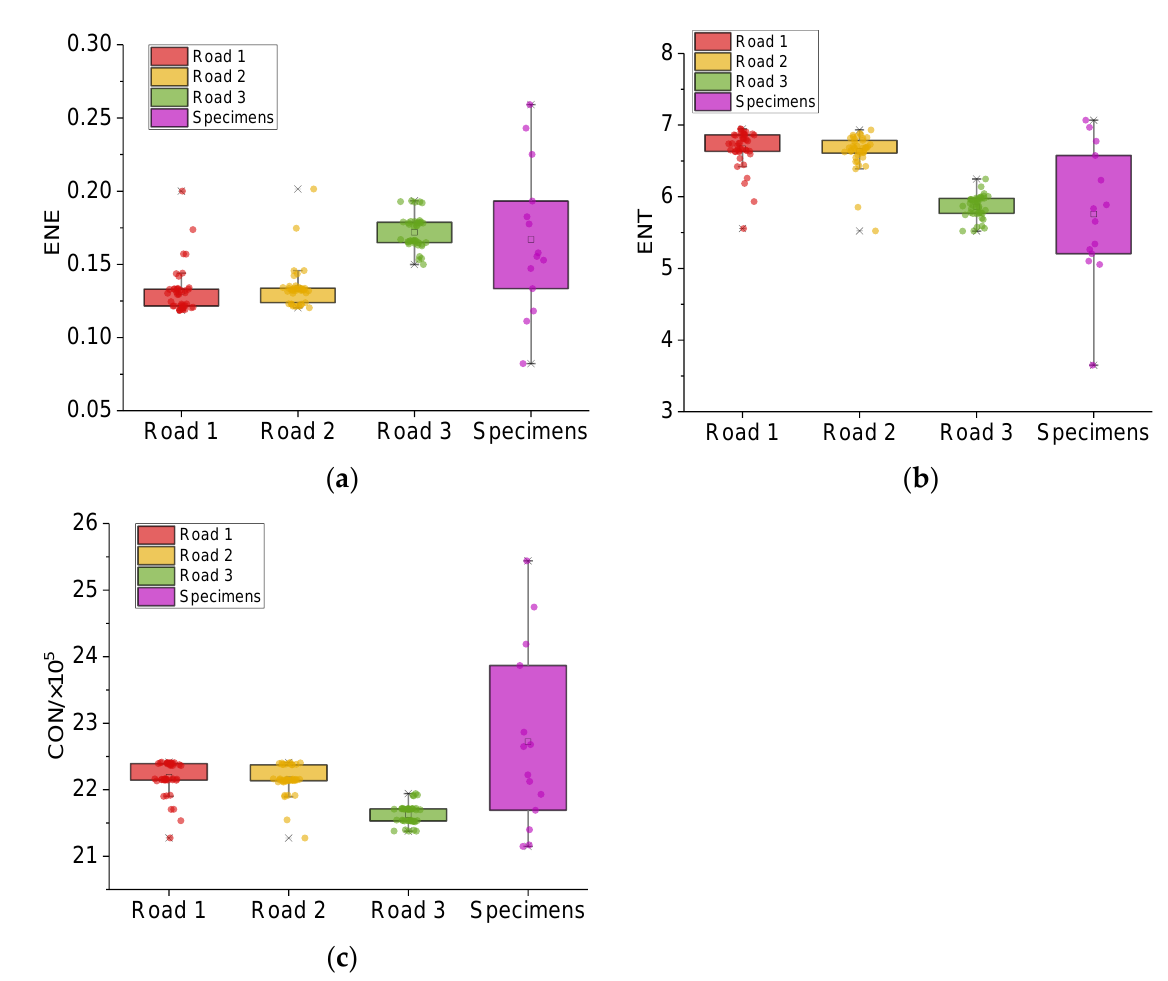
Figure 11. GLCM indicators of different roads and specimens. ( a ) ENEs of different roads and specimens. ( b ) ENTs of different roads and specimens. ( c ) CONs of different roads and specimens. Similar to the texture spectrum indicator, the GLCM indicators of roads 1 to 3 show